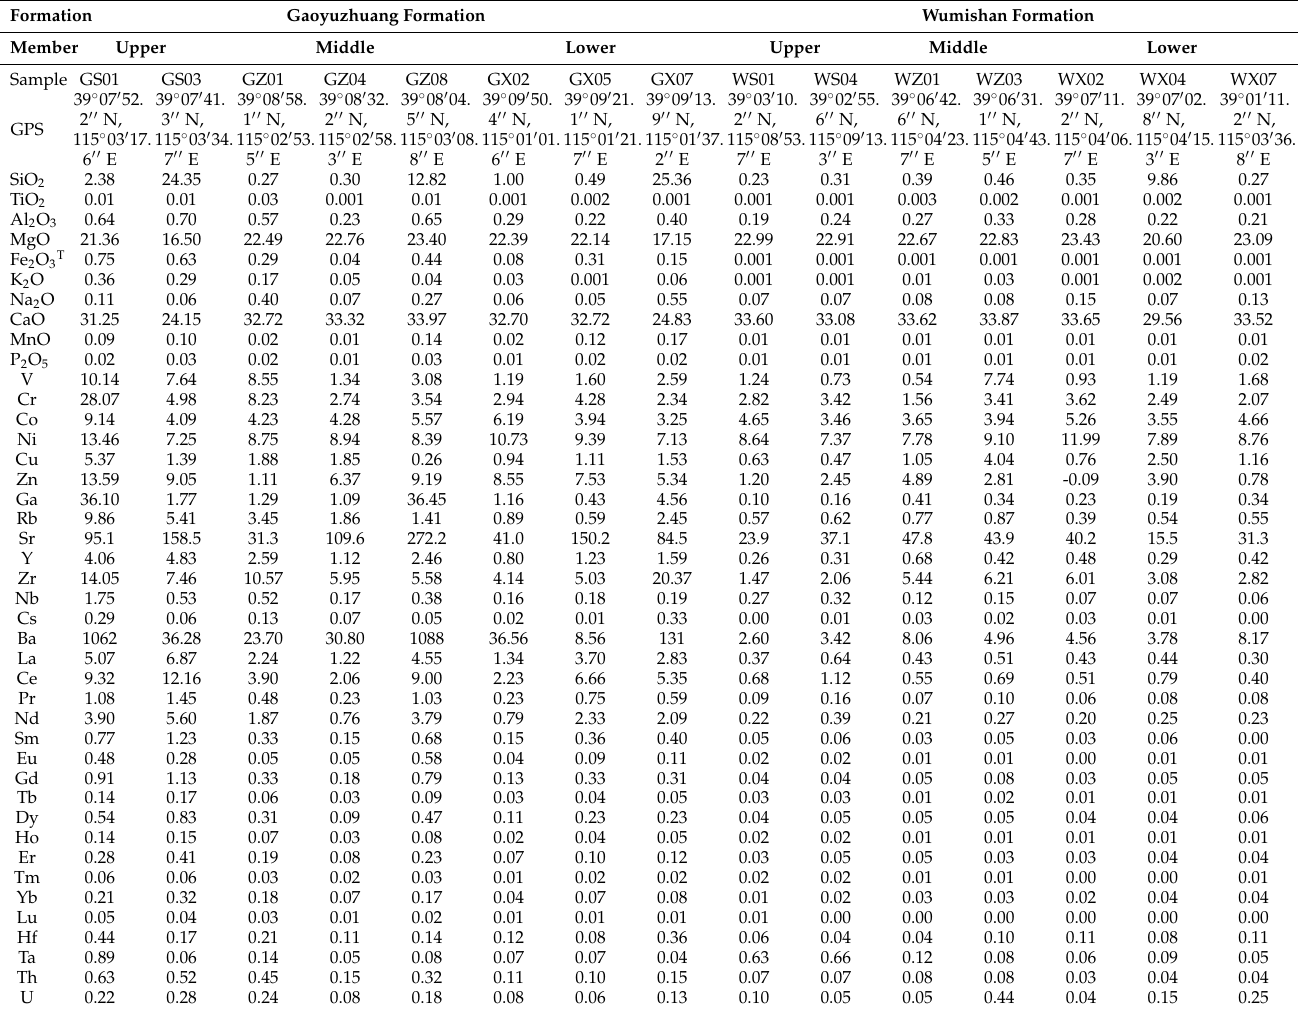
Table 1. Major element (wt.%) and trace element (ppm) compositions of the carbonate rocks in the Gaoyuzhuang and Wumimshan